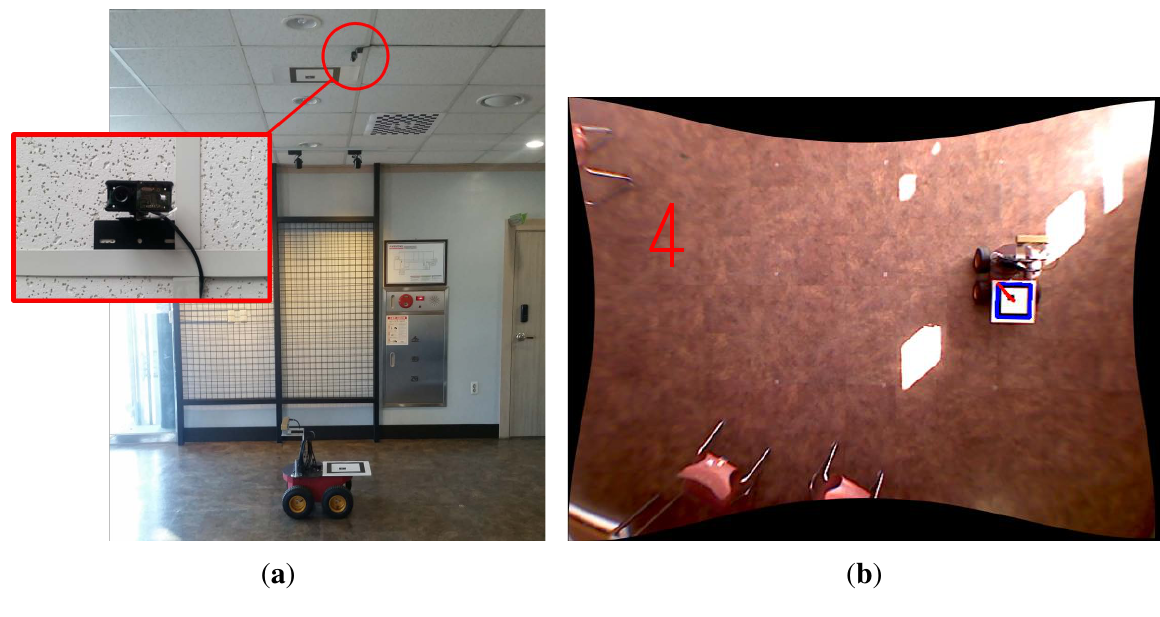
Figure 6. Ground truth system based on global vision sensor. ( a ) Installed camera on the ceiling for the ground truth system; ( b ) The image processing result for ground truth